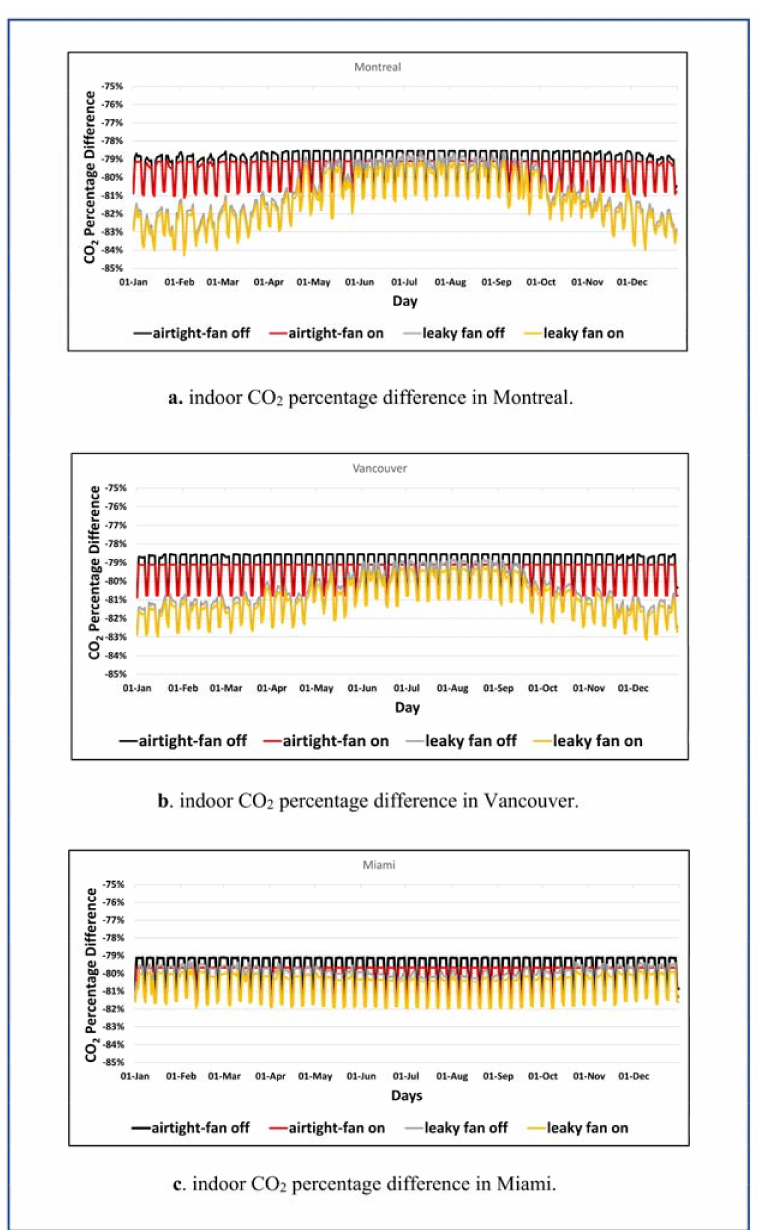
Figure 5. Comparison of the simulated CONTAM results of daily indoor CO 2 concentration with acceptable level of ASHRAE Standard 62.1 for ( a ) Montreal, ( b ) Vancouver, and ( c ) Miami